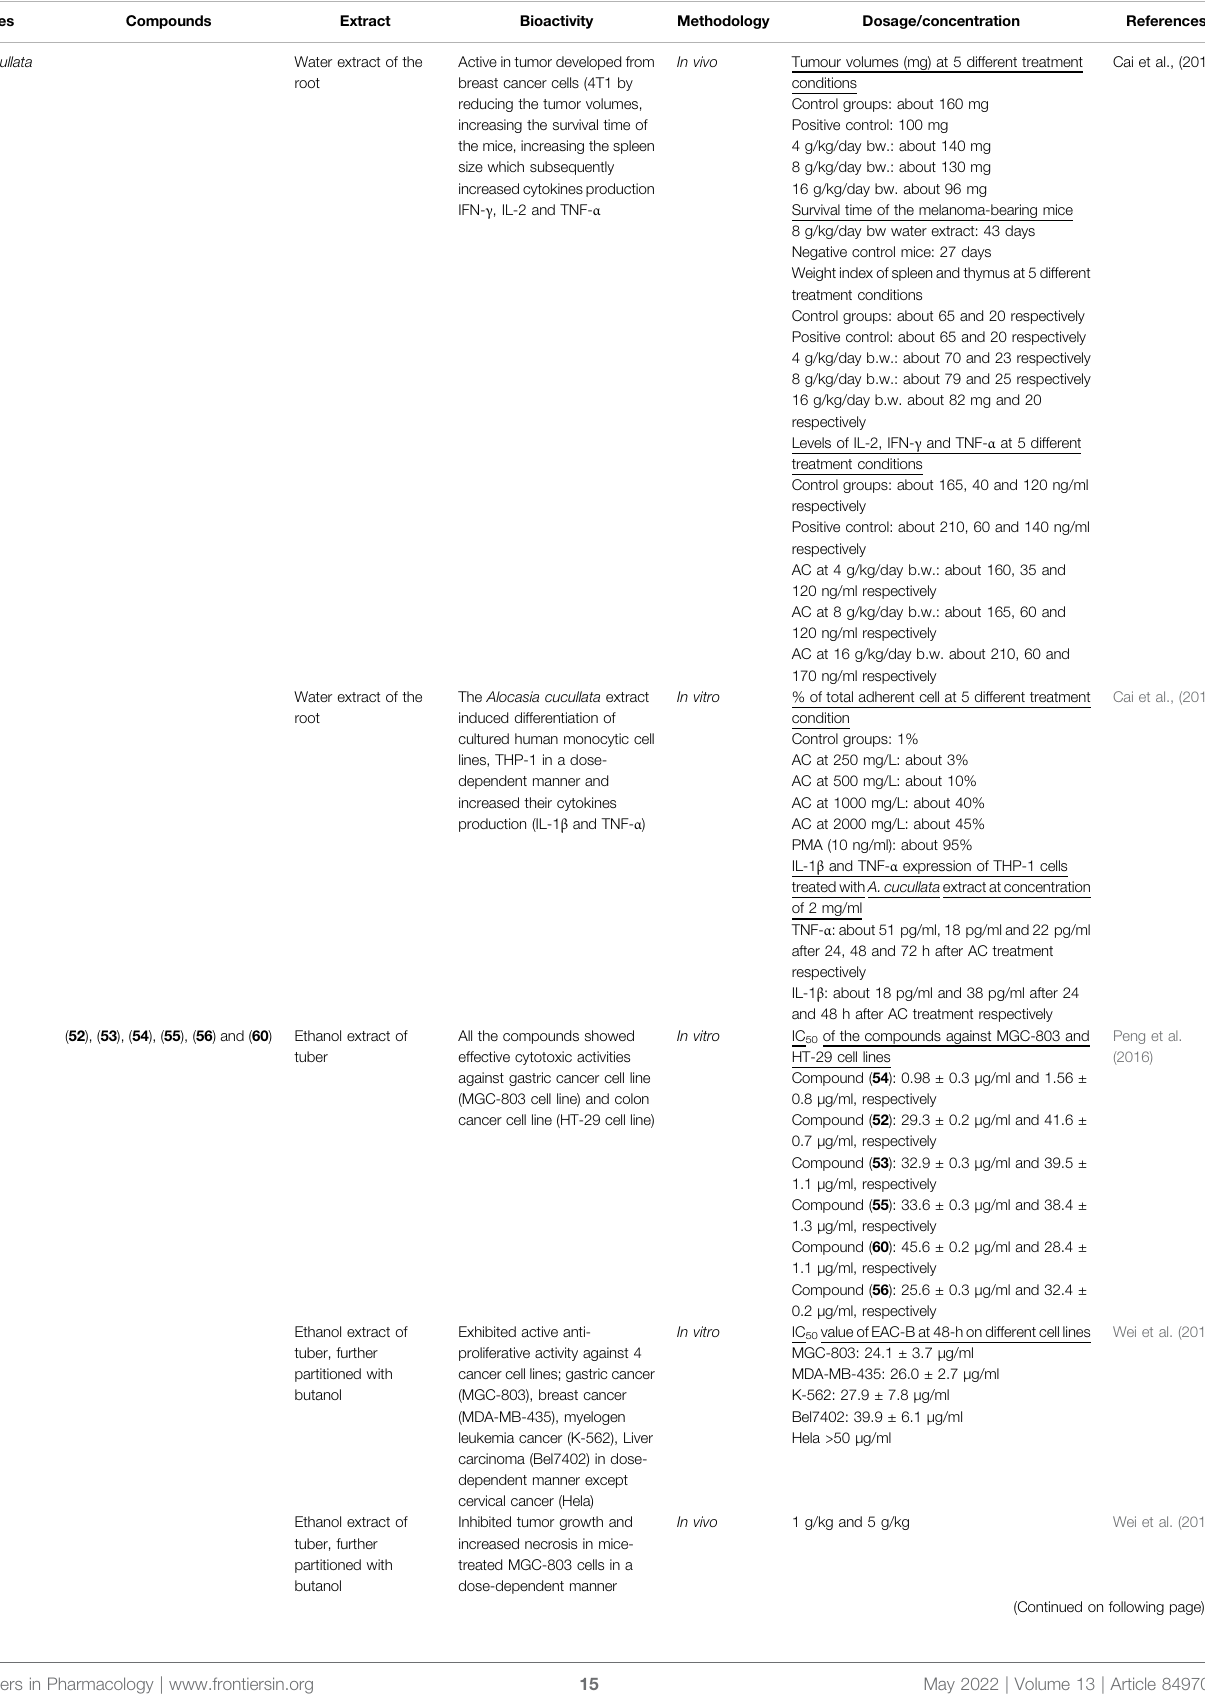
TABLE 4 | Anticancer activity of Alocasia species.